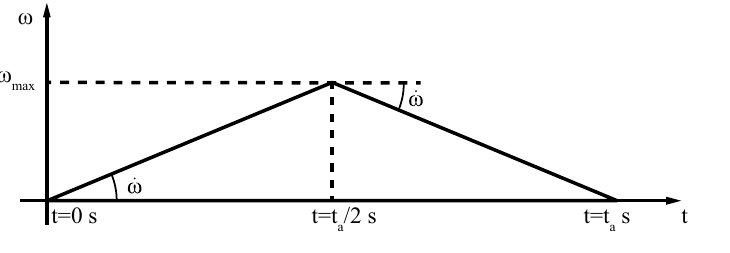
Figure 9. Angular velocity for rotating a deg in t a s.